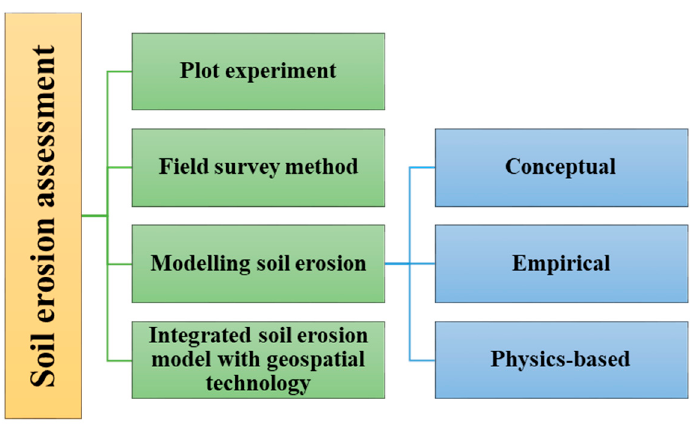
Figure 2. Classification of soil erosion assessment methods.